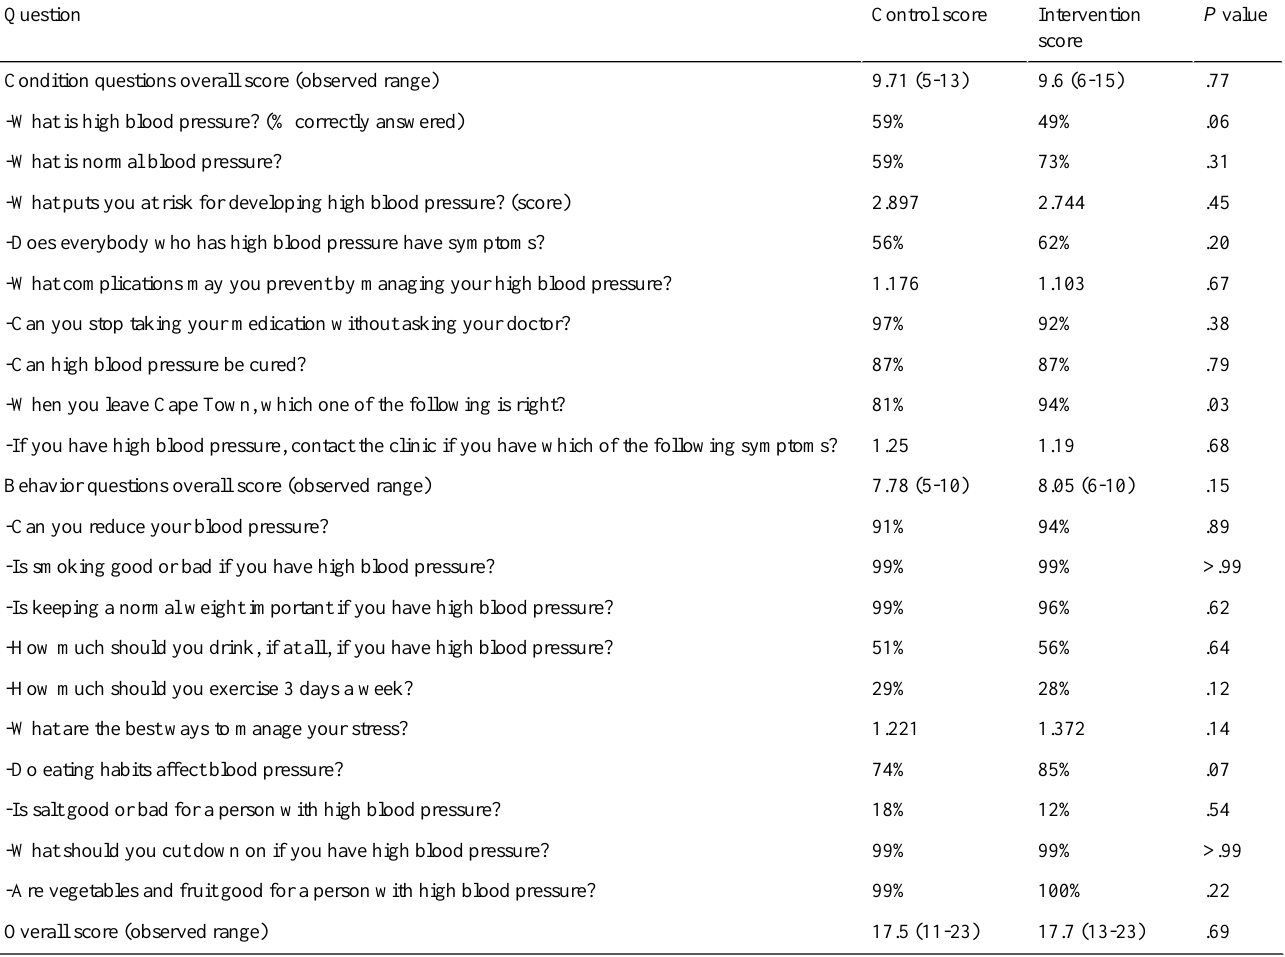
Table 2. Knowledge scores for control and intervention groups at exit.